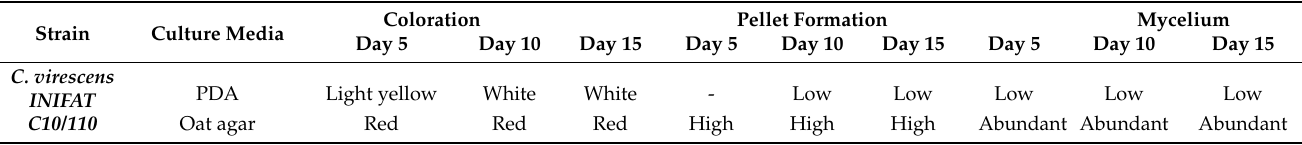
Table 3. Characteristics of C. virescens colonies in liquid medium of potato dextrose and oats respec- tively after 15